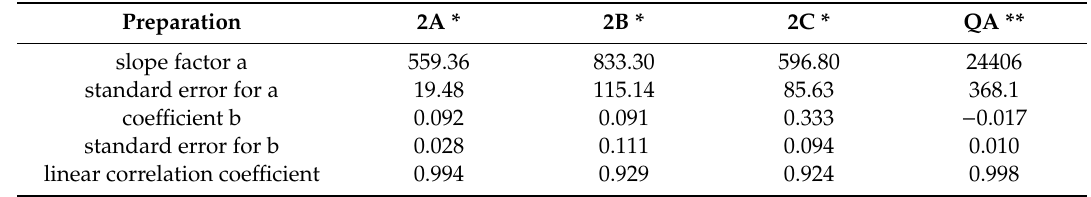
Table 2. Linear Correlation Parameters for the Standard Curve y = ax +